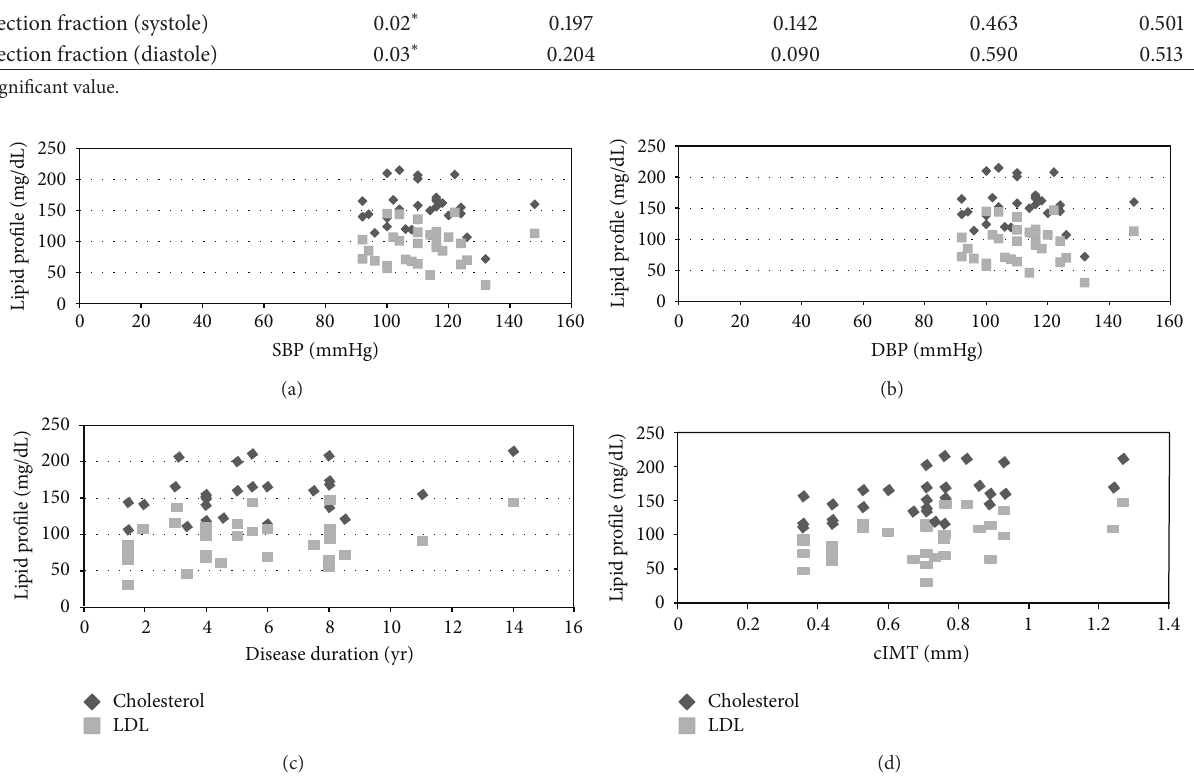
Figure 1: (a) Correlation of systolic BP with serum cholesterol and LDL. (b) Correlation of diastolic BP (DBP) with serum cholesterol and serum LDL. (c) Correlation of disease duration with serum cholesterol and serum LDL. (d) Correlation of cIMT with serum cholesterol and serum LDL. ∗ (Each pair of points represents single